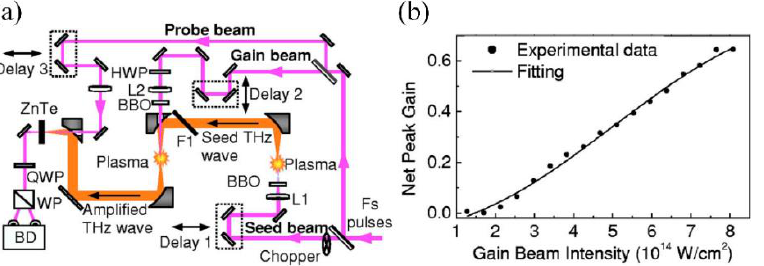
Figure 5. ( a ) Schematic diagram of laser-induced plasma amplification and detection of terahertz waves; ( b ) relationship curve between peak amplification factor and light excitation intensity [42].